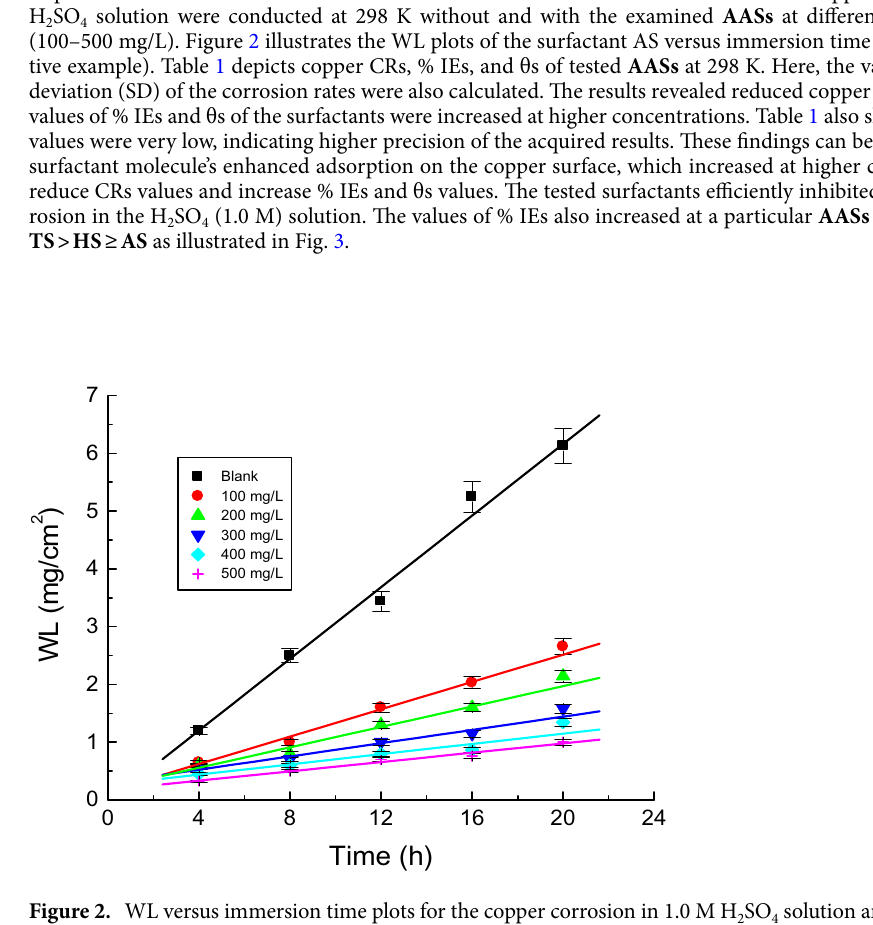
Figure 2. WL versus immersion time plots for the copper corrosion in 1.0 M H 2 SO 4 solution and in the presence of the surfactant AS at 298